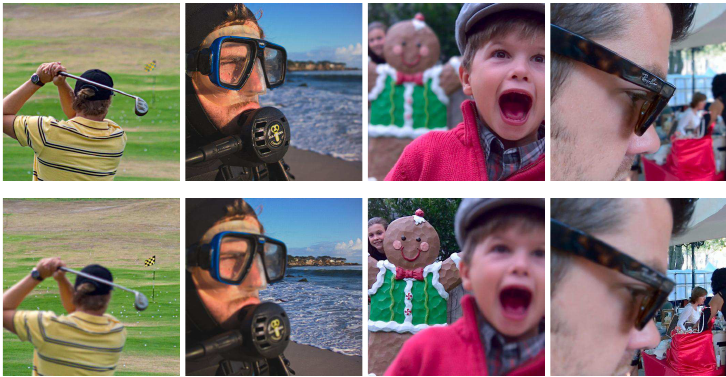
Figure 5. Examples of the source image pairs from the Lytro color multi-focus